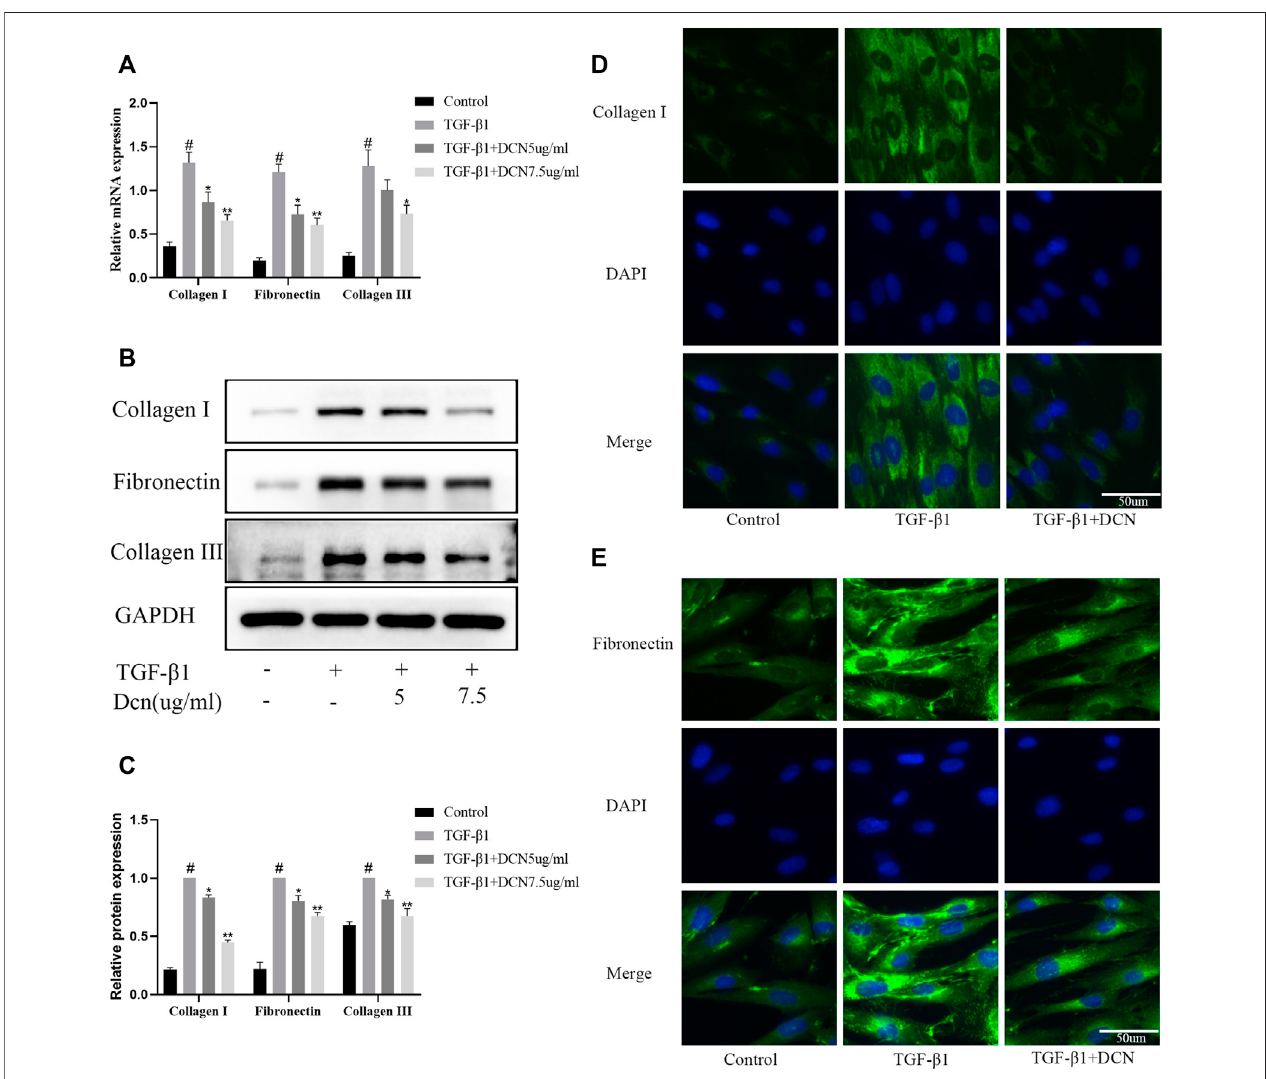
FIGURE 3 | Decorin (DCN) inhibits TGF- β 1-induced extracellular matrix synthesis. Fibroblasts were exposed to TGF- β 1 (5 ng/ml) with or without DCN (5 and 7.5 µg/ml) for 48 h. (A) Gene expression of fi bronectin, collagen I, and collagen III was detected by RT-qPCR. (B) Western blotting and (C) quantitative analysis of fi bronectin,collagenI,andcollagenIIIineachgroup. (D) CollagenIand (E) fi bronectinwereobservedbyimmuno fl uorescenceaftercellsweretreatedwithTGF- β 1(5 ng/ ml) with or without DCN (7.5 µg/ml). # p < 0.05 vs control group; * p < 0.05 vs TGF- β 1 group; ** p < 0.01 vs TGF- β 1 group.